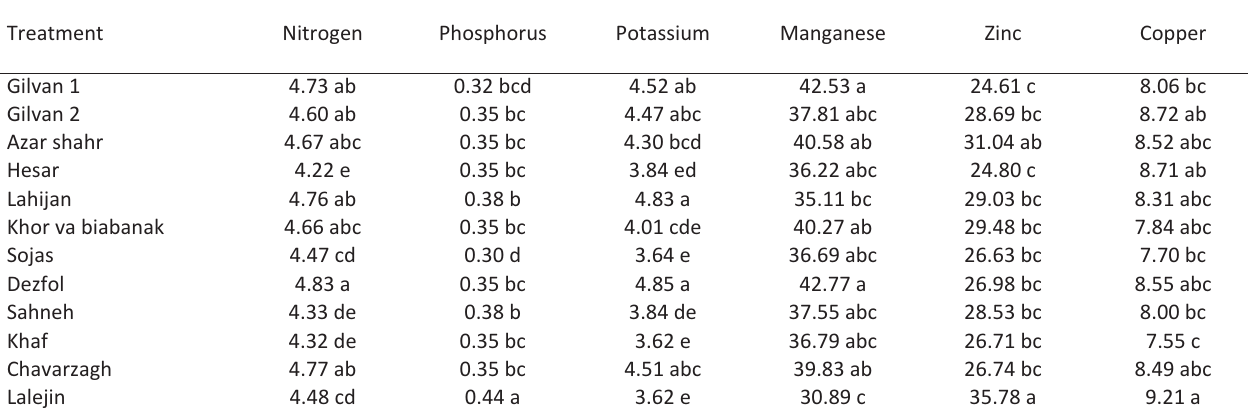
In each column different letters mean significant differences